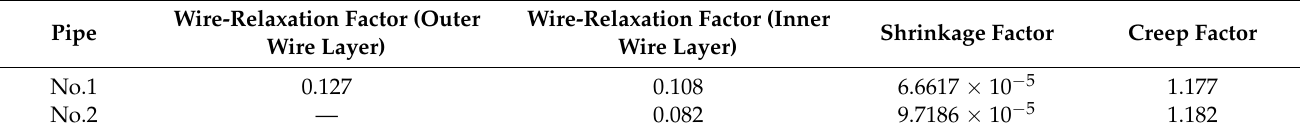
Table 5. Wire-relaxation, creep and shrinkage factors.